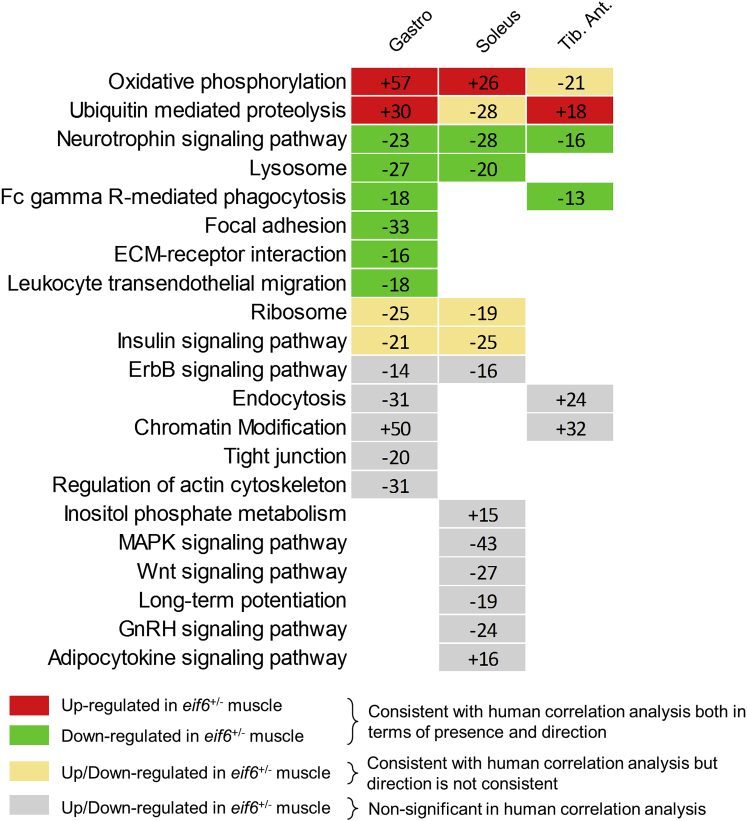
Eif6 Haploinsufficiency in Mouse Skeletal Muscle Recapitulates the Predictions from the Human ModelThe figure shows the KEGG pathways enriched in genes up- or downregulated in the three Eif6+/− skeletal muscle types compared to WT of the same muscle type (FDR < 10%). The number and the direction of change (positive, upregulated; negative, downregulated) of the enriched genes are indicated. Pathways colored red and green represent those matching the human Eif6 correlation analysis (shown in Figure 3D and 3E) of consistency between direction of correlation and change in expression. Pathways highlighted in yellow represent those terms matching the human correlation analysis but without consistency between direction of correlation and change in expression.